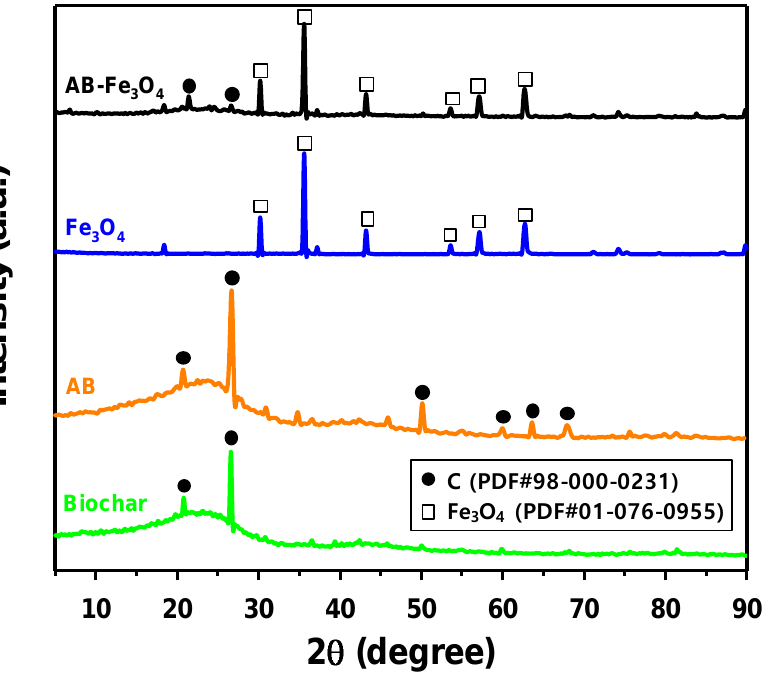
Figure 1. Powder X-ray diffraction (PXRD) patterns of biochar, activated biochar (AB), Fe 3 O 4 , and AB-Fe 3 O 4 .